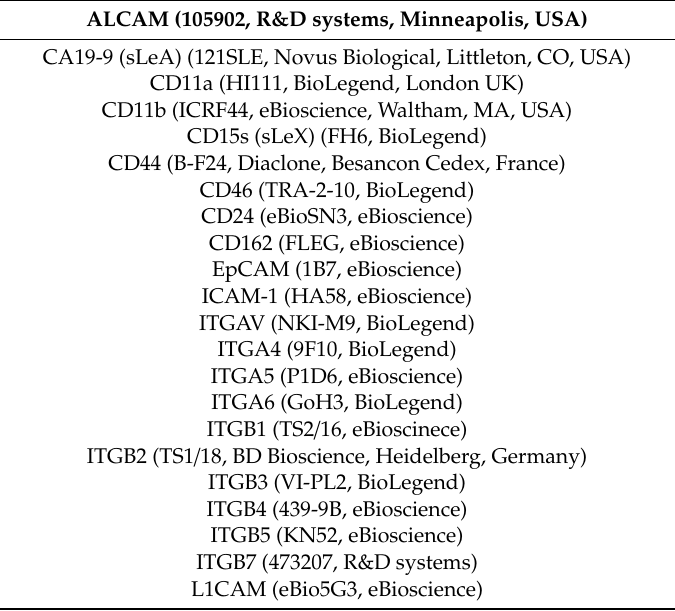
Table 3. Commercial antibodies used for